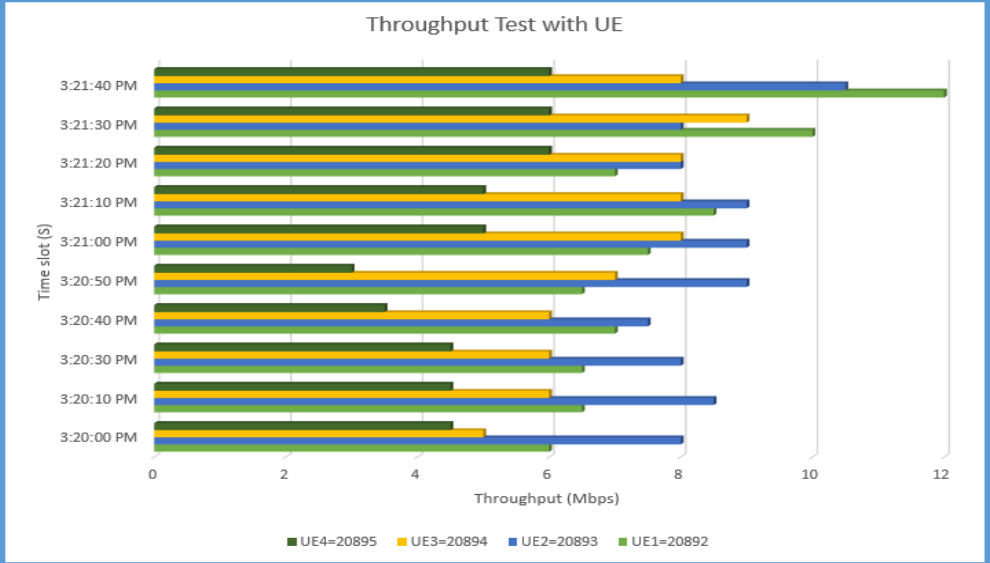
Figure 14. Iperf throughput test results with simulated